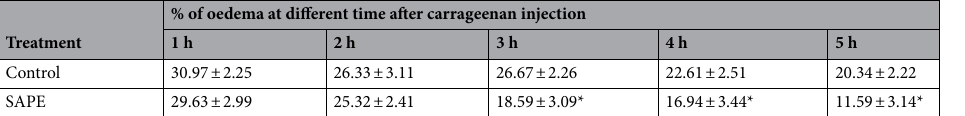
Table 3. Effect of SAPE on the carrageenan induced paw oedema model. Results in mean ± SD (n = 4). *Differ significantly from the control group ( P ≤ 0.05).